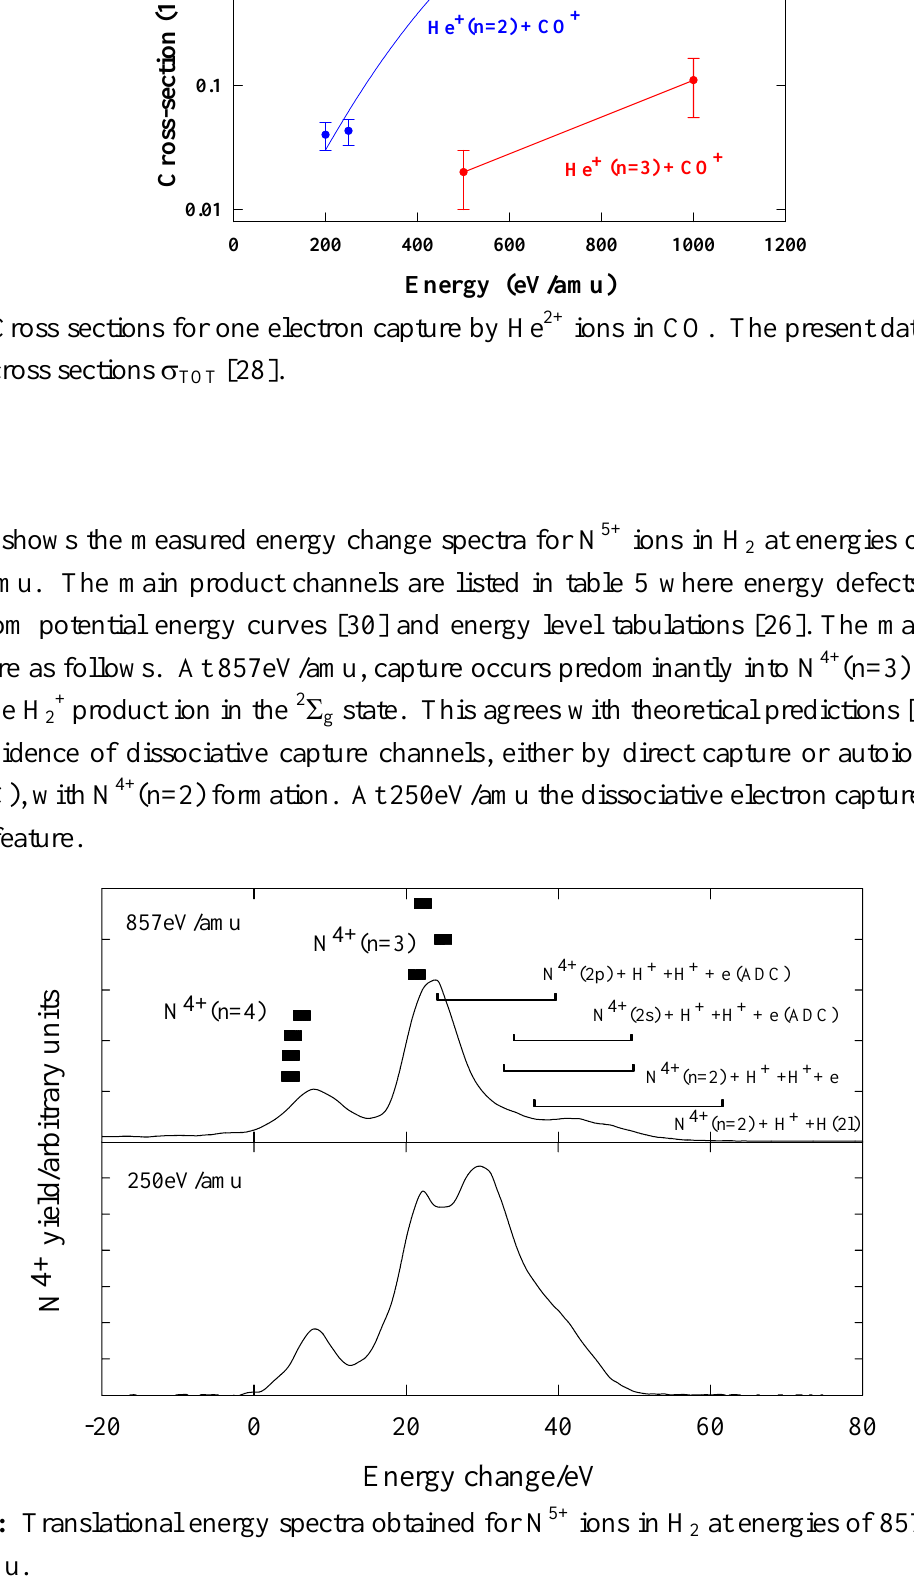
Figure 11: Translational energy spectra obtained for N 5+ ions in H 250